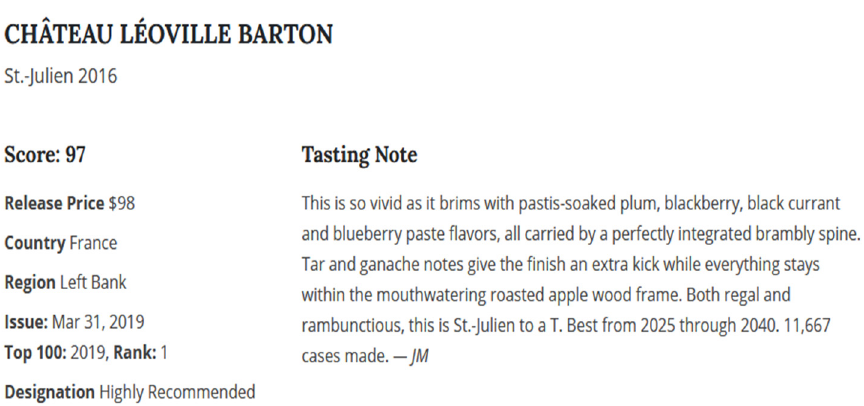
Figure 1. Example of wine reviews on WineSpectator.com and their suggested holding years.